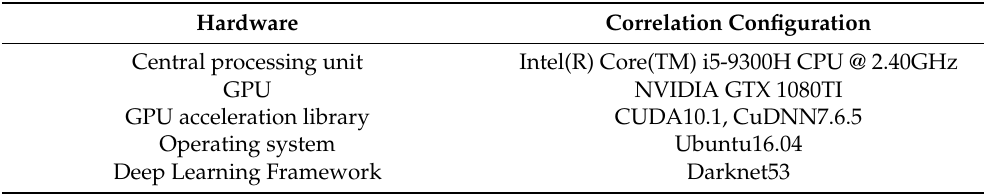
Table 2. The hardware configuration of the experiment in this